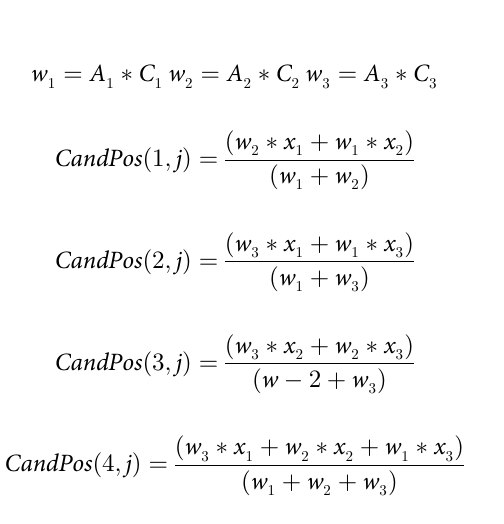
Algorithm 2 : Elastic Grey Wolf Optimization algorithm